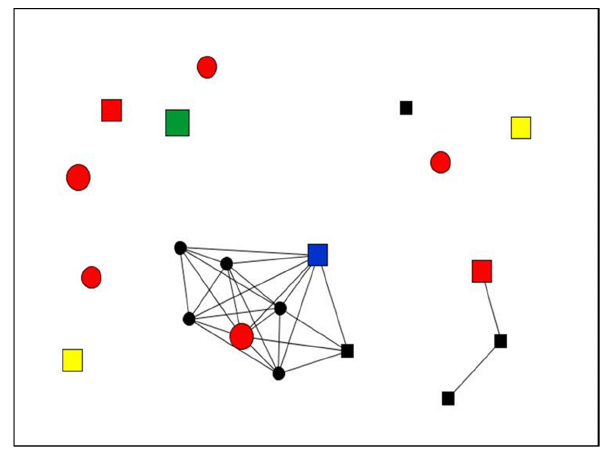
Figure 2. Graph Case 1. Woman (40 years old), living with chronic pain for 14 years.